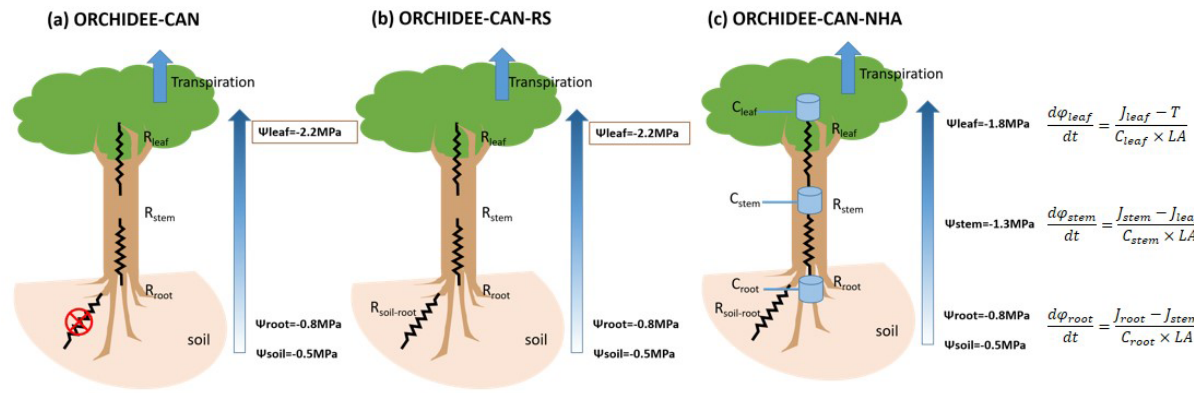
Figure 1. Schematic framework for hydraulic architecture in (a) ORCHIDEE-CAN, (b) ORCHIDEE-CAN-RS and (c) ORCHIDEE-CAN- NHA. The framed rectangles represent fixed values during the simulation. In ORCHIDEE-CAN and ORCHIDEE-CAN-RS, R leaf is related to leaf conductivity and leaf area. R stem is related to sapwood conductivity that can vary with cavitation and sapwood area. R root is related to fine root conductivity and root biomass. In ORCHIDEE-CAN-NHA, transport conductance of each organ is a function of their organ-specific water potential, maximum conductance and water potential when loss of 50% conductance occurred. C leaf , C stem and C root represent water storage capacitance. J leaf , J stem and J root are vertical water transport to leaf, stem and root, respectively. LA is total leaf